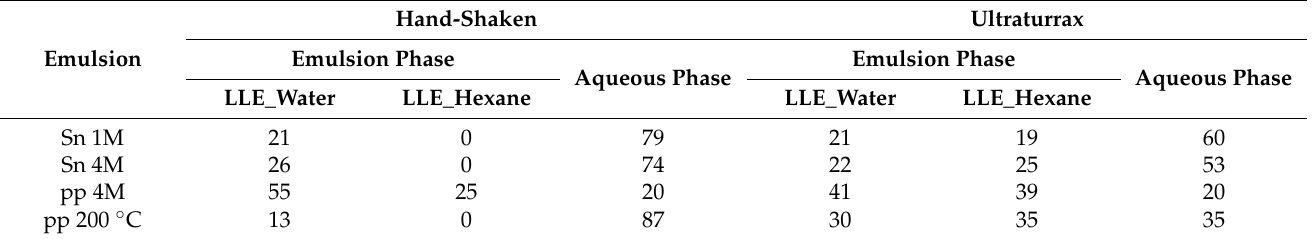
Table 3. Yields (%) of partition of the material after phase separation, emulsion, and aqueous phases in hand-shaken and ultraturrax emulsions, after 1-month